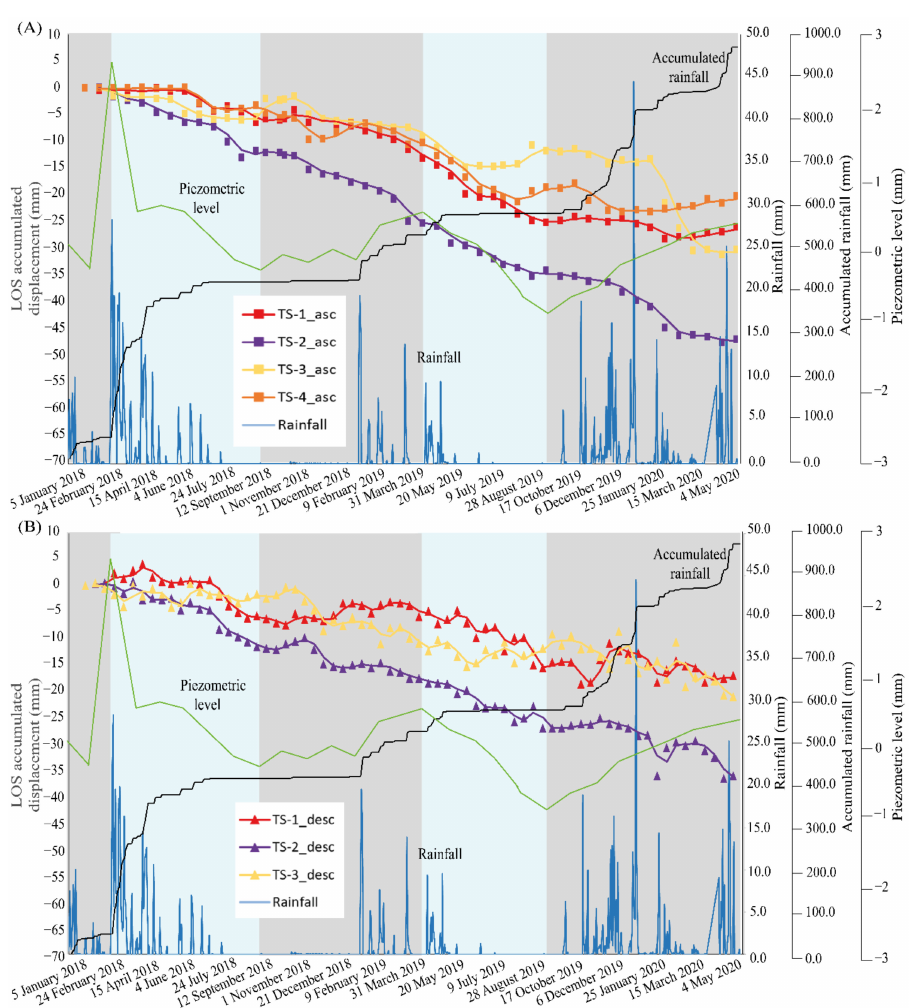
Figure 8. Deformation time series (mm), daily rainfall dataset (mm), accumulated precipitation (mm), and piezometric level (m) between January 2018 and April 2020. ( A ) Time series from ascending dataset; ( B ) time Series from descending dataset. See location of TS in Figure